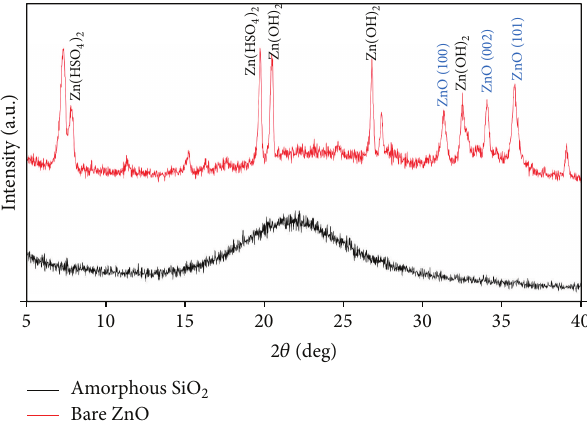
Figure 8: X-ray diffraction plot of amorphous SiO 2 used in the